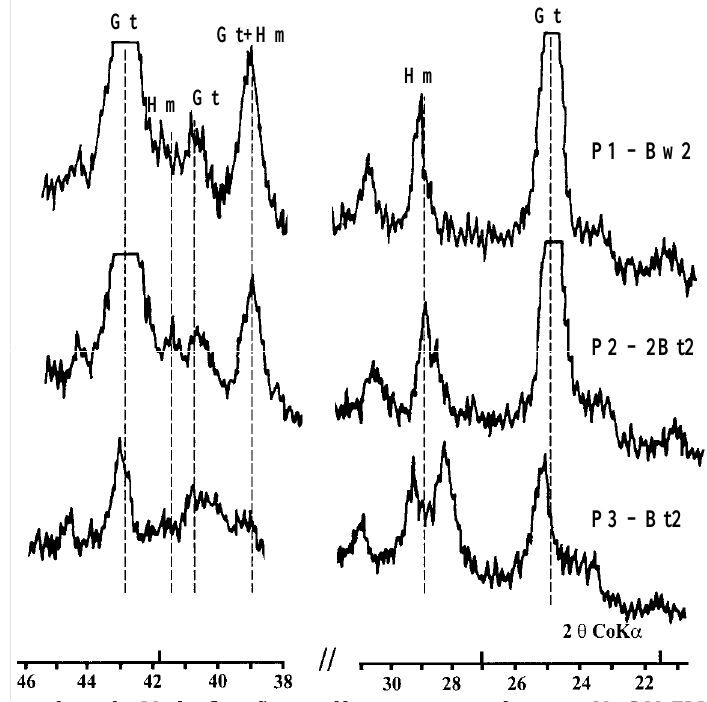
Figura 3. Difratogramas de raio-X da fração argila concentrada com NaOH 5M (não orientada) dos horizontes diagnósticos subsuperficiais dos perfis desenvolvidos de rochas graníticas e gnáissicas (Hm: Hematita e Gt: Goethita).